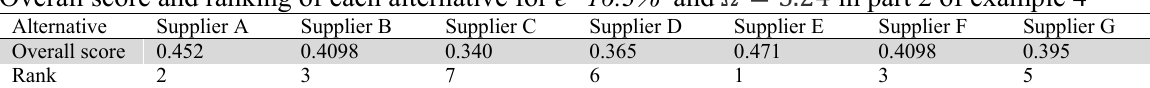
Overall score and ranking of each alternative for e=16.3% and (cid:2007) (cid:3404) 5.24 in part 2 of example 4